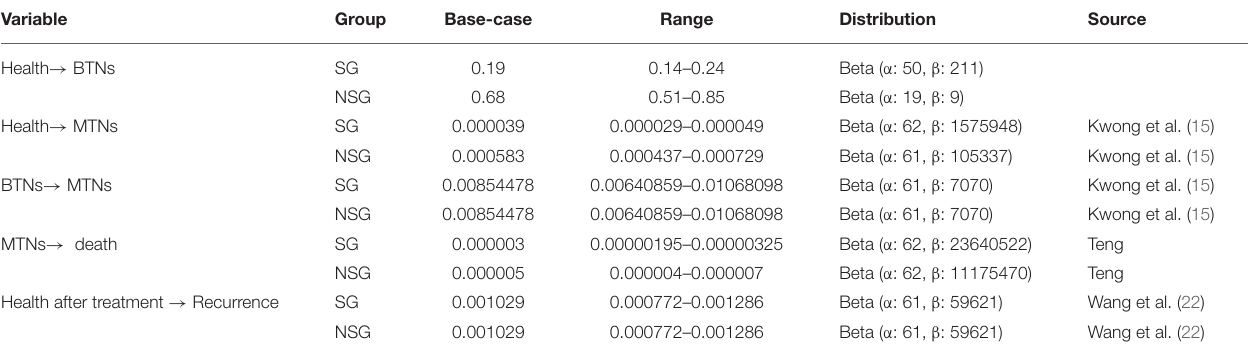
TABLE 3 | Probability variables used in the modeling.